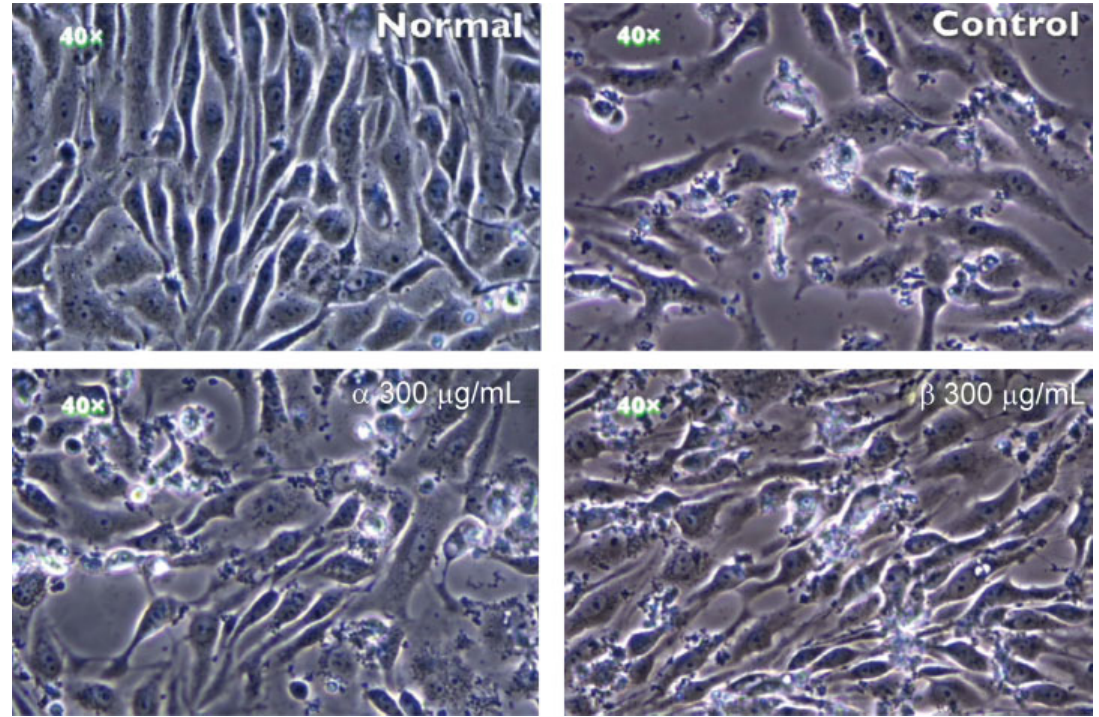
Fig. 3 Morphological changes of endothelial cells after treatment with histone H4. After exposure to various concentrations of histone H4, the morphological changes of endothelial cells were observed. Increasing concentrations of histone H4 resulted in typical signs of cellular damage, including pleomorphism, rupture of the nuclear or plasma membrane, a shrunken cytosol, disruption of the intercellular junction, and the presence ofcellular debris. The above changes wereattenuated by 300 μ g/mLof α - or β -antithrombin, and the effect of β -antithrombin was more prominent than that of α -antithrombin. TH Open Vol. 1 No.